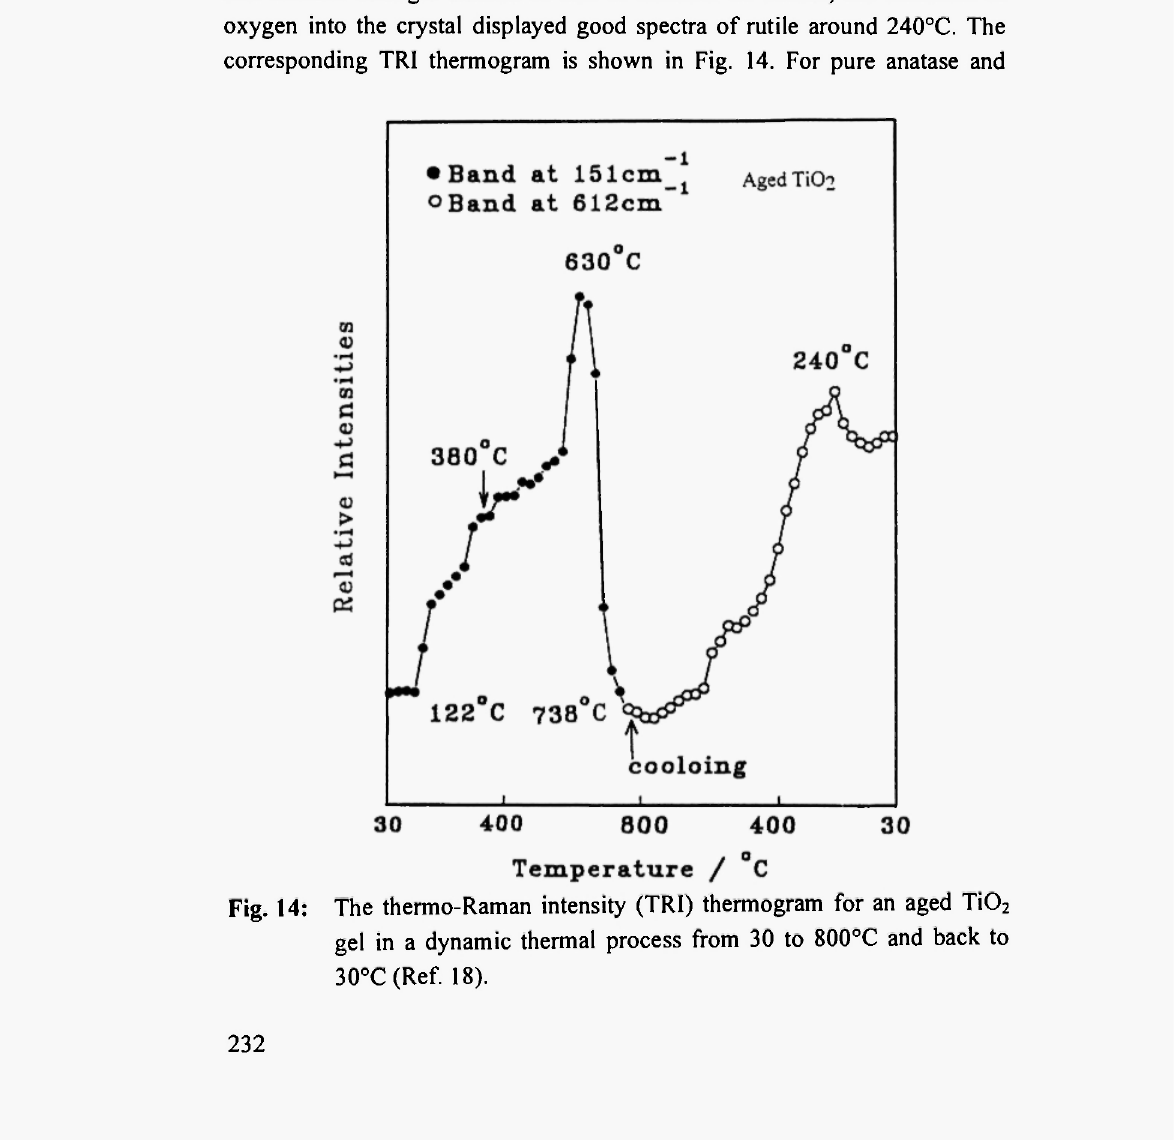
Fig. 14: The thermo-Raman intensity (TRI) thermogram for an aged Ti0 2 gel in a dynamic thermal process from 30 to 800°C and back to 30°C (Ref.